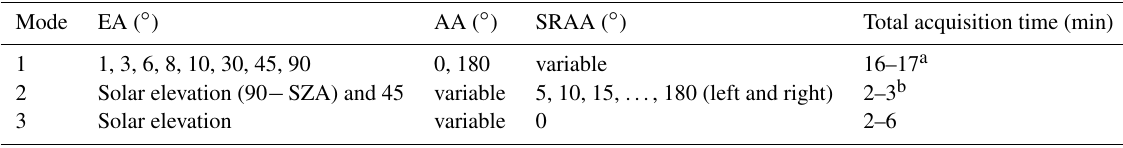
Table 2. Geometry of measurements and configuration used during the TCAP field